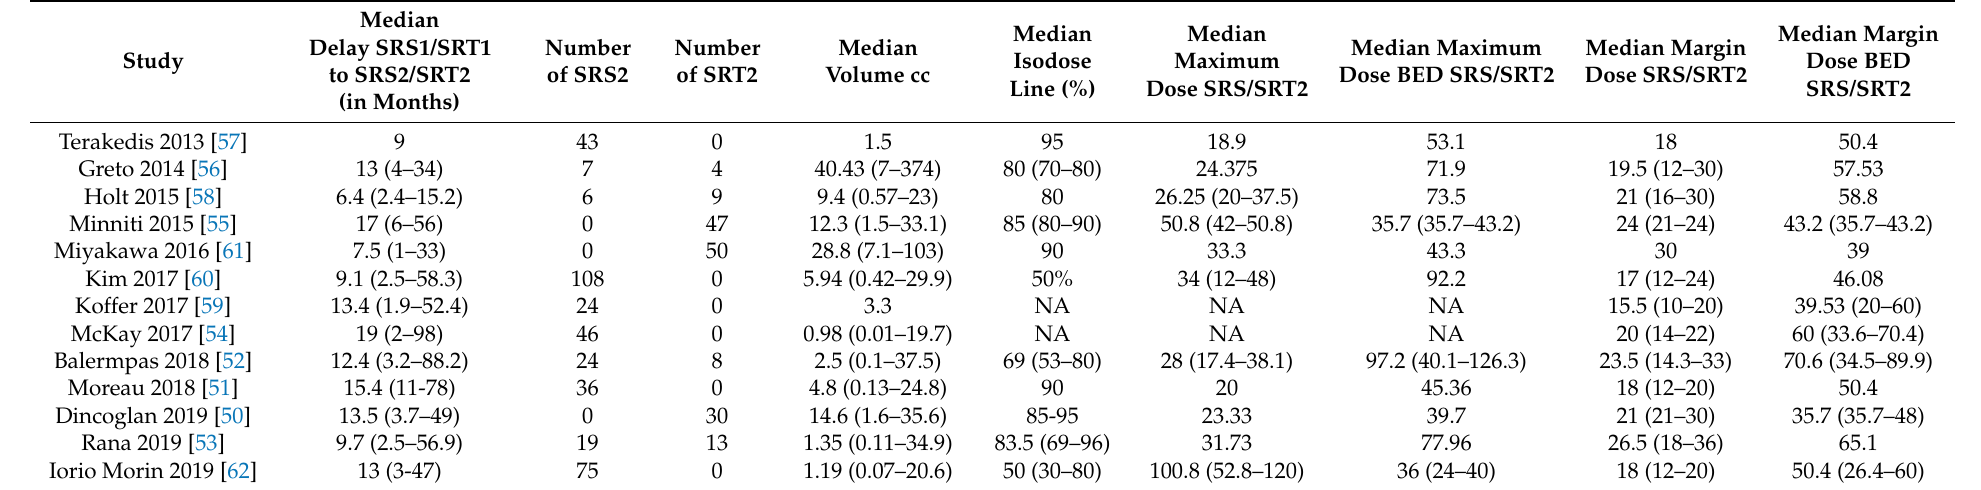
Table 4. SRS2/SRT2 treatment